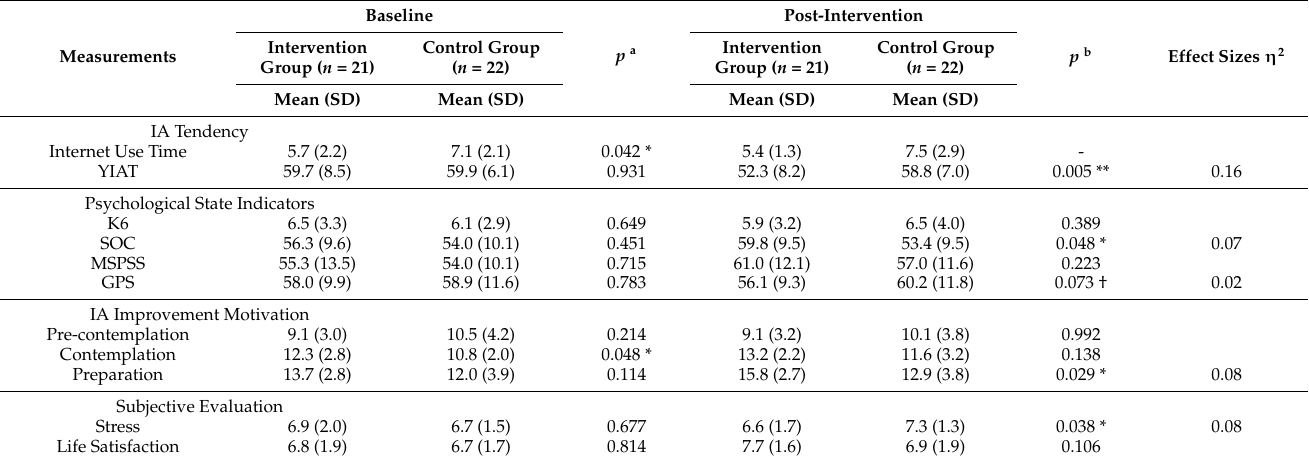
Table 3. Results of the evaluation of the effects before and after the